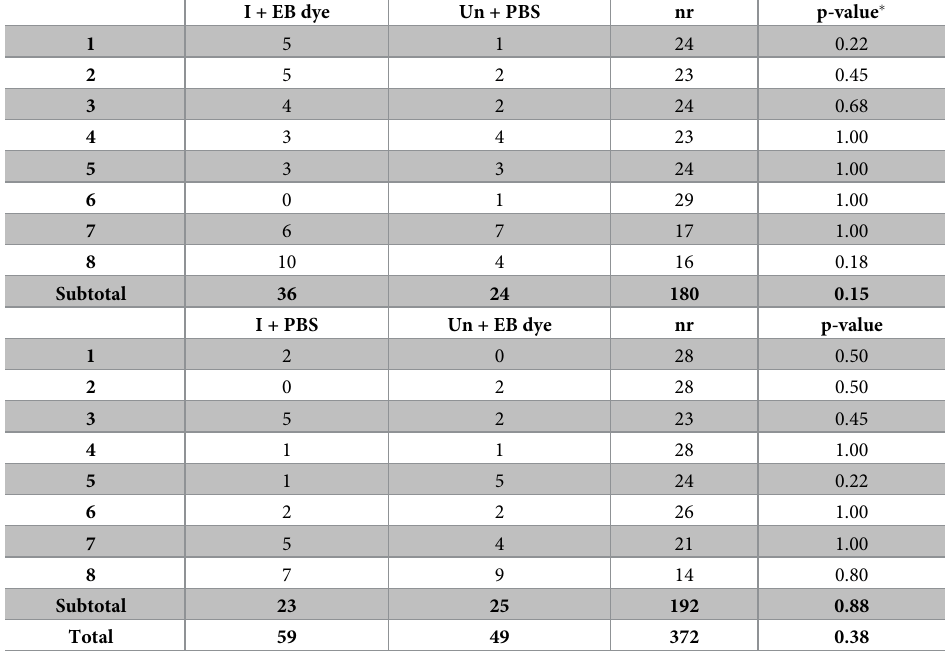
Total 0.38 � p-value for the exact test of H 0 :p = 0.5 vs H 1 :p 6¼ 0.5 where p = the probability of a sand fly to bite the infected mouse among those sand flies which have bitten any